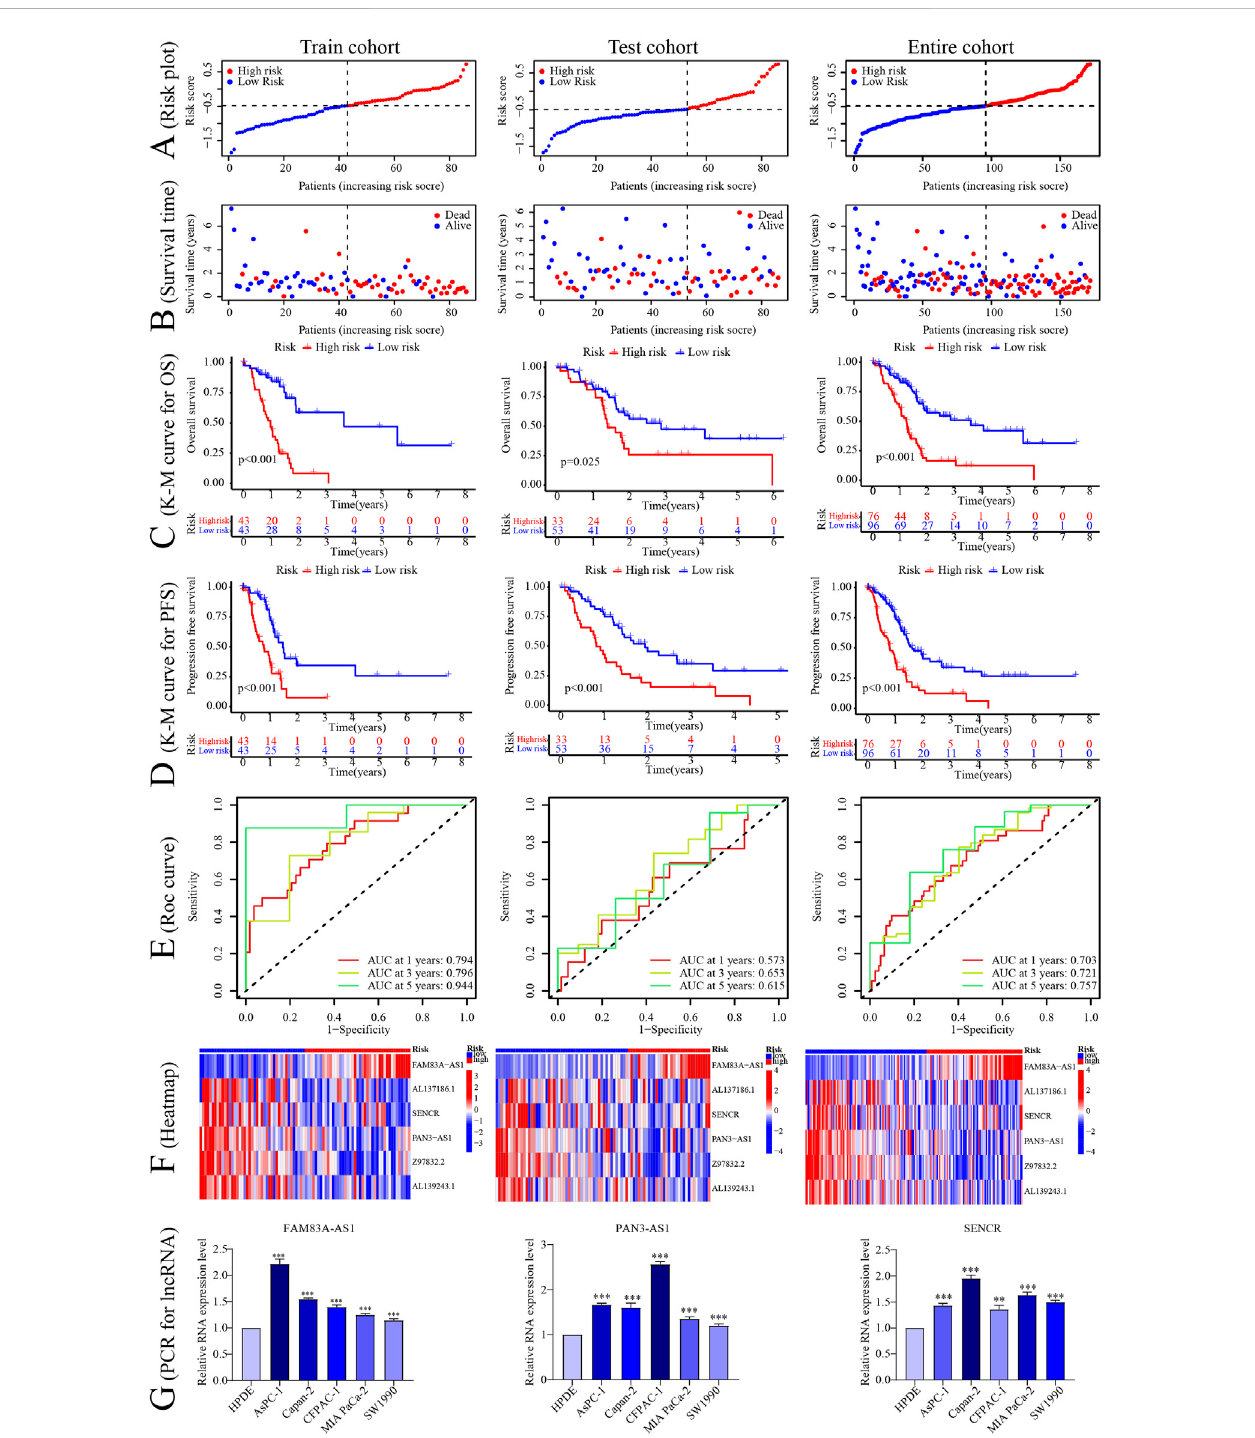
FIGURE 4 Construction of the CRLncs prognostic signature. (A – F) The risk score, survival status, Kaplan-Meier plot survival cure of OS and PFS, ROC curve predicted the 1/3/5-year OS, and heatmap of 6 signature CRLncs in different risk PC patients in the TCGA-train, test, and entire cohort. (G) The PCR